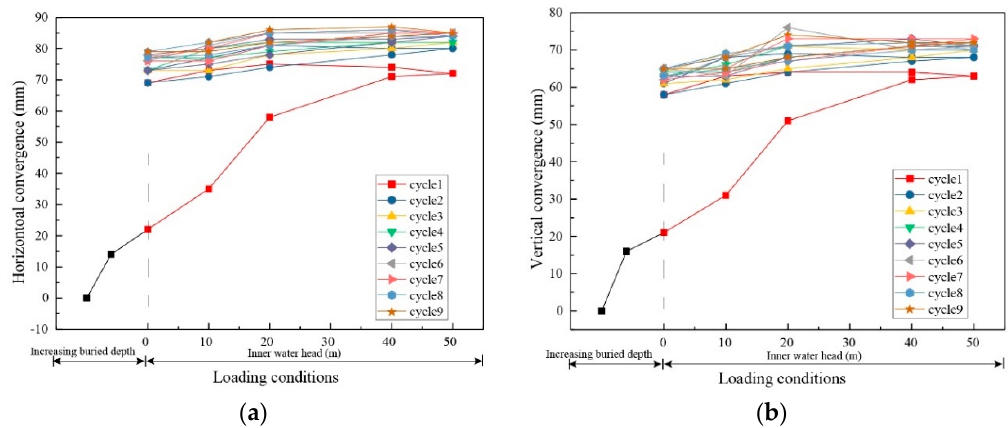
Figure 12. The full-ring convergence deformation of the stormwater sewage and storage tunnel under cyclic loadings: ( a ) horizontal; and ( b ) vertical.